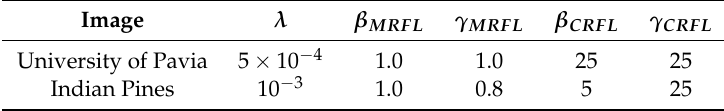
Table 1. Optimal values of the